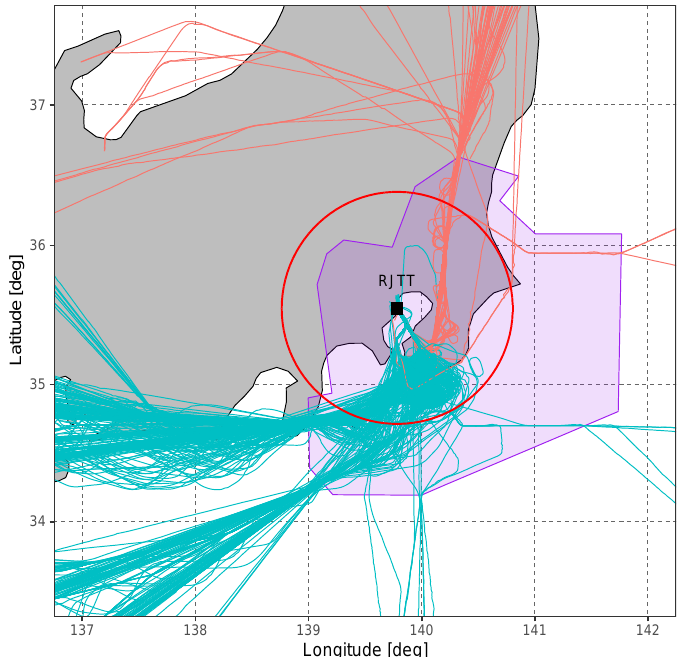
Figure 5. Actual radar tracks bound for RJTT coming from a northern direction (orange lines) and southern direction (blue lines) in the northerly wind operation in a day in October 2019. Tokyo Ap- proach Control Area (TACA) is bounded by a purple polygon. The radius of the red circle is 50 NM centered on